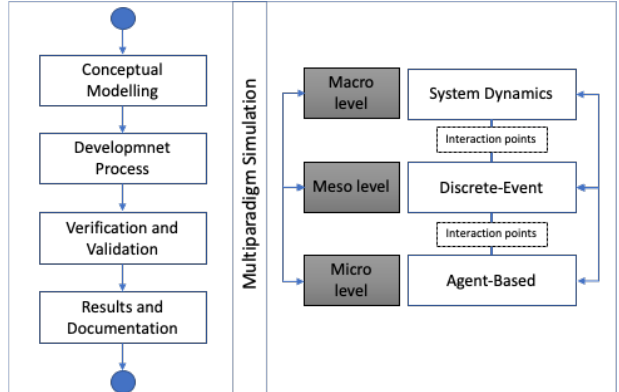
Figure 4. The Agent Based approach. Source: AnyLogic®.